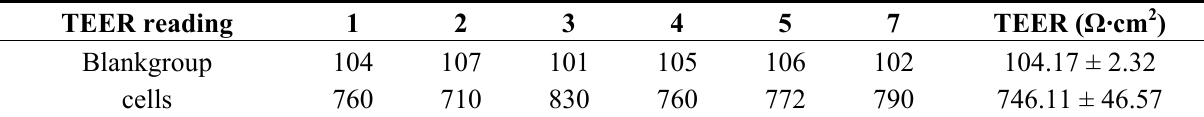
Table 2. Measured value of transepithelial electrical resistance (TEER) on Caco-2 cell monolayers. Control group means the no-cell blankground wells, test group means Caco-2cells wells. The TEER values of test group cells were 746.11 ± 46.57 Ω ·cm 2 , this indicated good monolayers integrity which was subjected to experimentation.